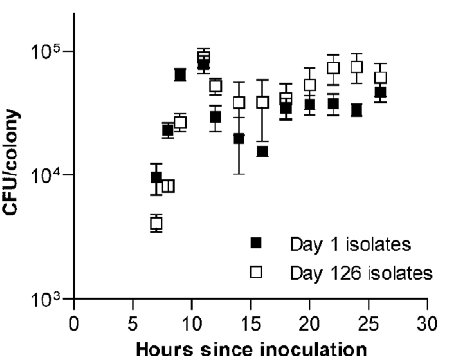
Figure 2. Time series examination of the development of S. pneumoniae colonies. Average CFU/colony values 6 S.E.M. are shown for 6 serial transfer lines after 7 to 26 h of incubation on THY agar plates. Values are higher during exponential phase (7 to 11 h) for day 1 isolates ( F [ 1,40 ]=4.51, P =0.04) but higher during stationary phase (12 to 26 h) for day 126 isolates ( F [1,80] =11.31, P =0.0012).